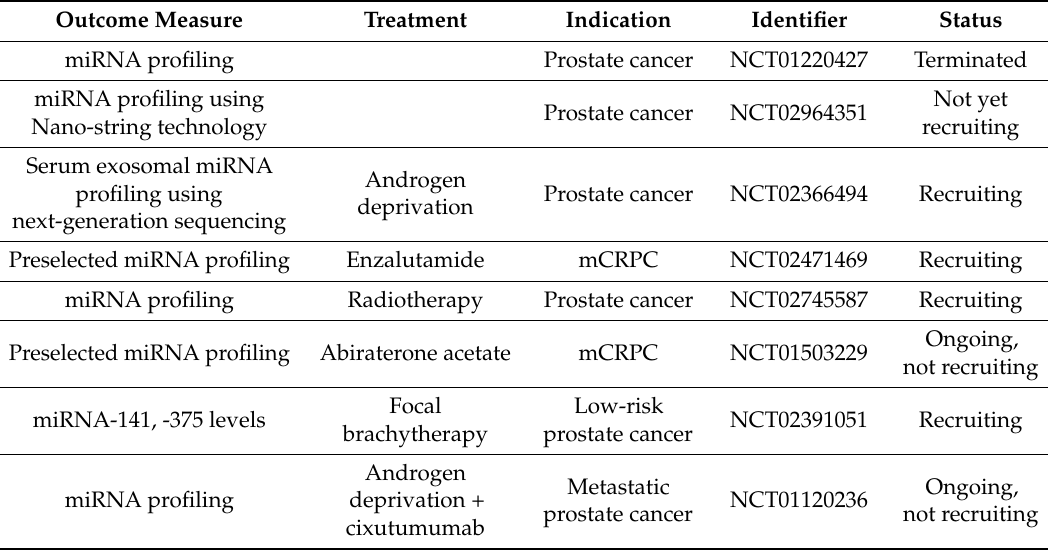
Table 3. Clinical studies in prostate cancer, including metastatic castration-resistant prostate cancer (mCRPC), evaluating microRNAs (miRNA) as potential biomarkers. Source: